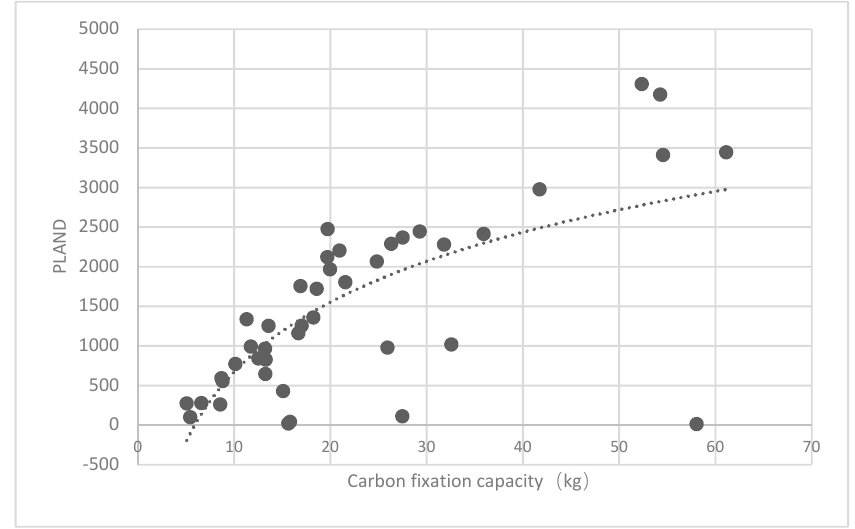
Figure 11. Association between the percentage of patches (PLAND) index for forest land, and carbon fixation capacity.